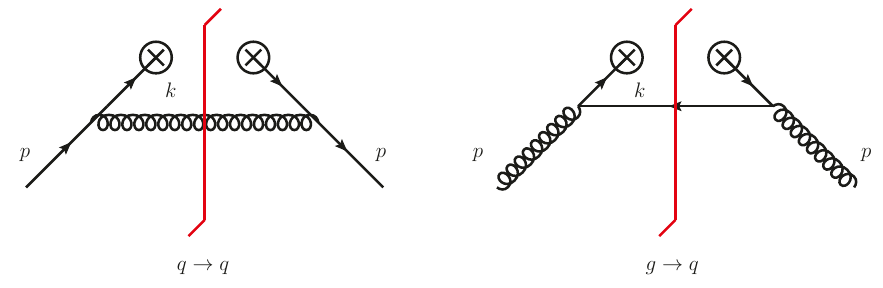
Figure 2 . Cut diagrams for the bare coe(cid:14)cient functions at